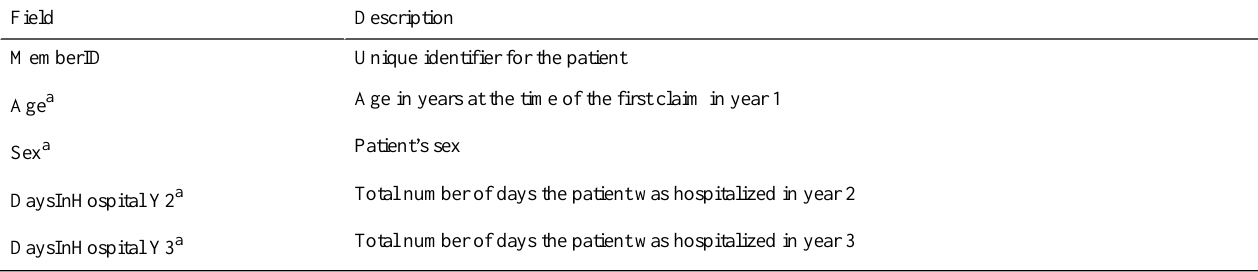
Table 2. Description of the fields in the patients data table.